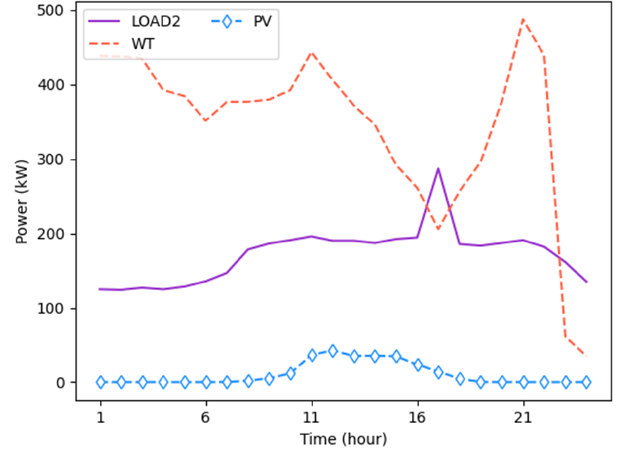
Figure 5. WT, PV output, and load power curve of MG 1.